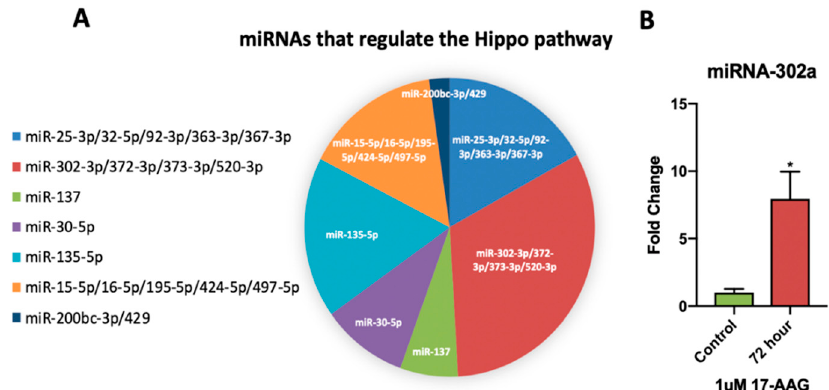
Figure 8. The miRNA-302 cluster is a significant regulator of the Hippo pathway ( A ). Adult CPCs treated with 1uM of 17-AAG for 72 h had elevated miRNA-302a transcript levels compared to non-treated control cells ( B ). * p < 0.05. Fold changes are shown as the mean ± SEM. All samples were run in triplicate.